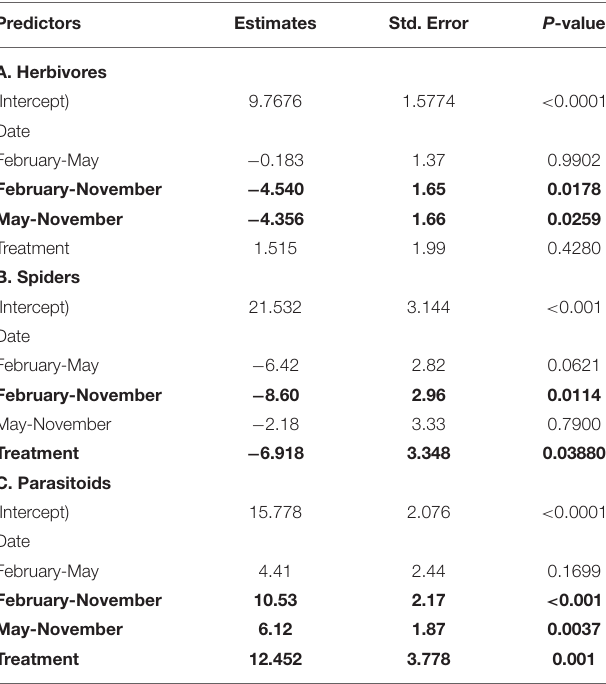
TABLE 1 | Generalized linear mixed model results and pairwise estimated marginal means contrasts of dates for herbivores (A) , spiders (B) , and parasitoids (C) . Predictors Estimates Std.